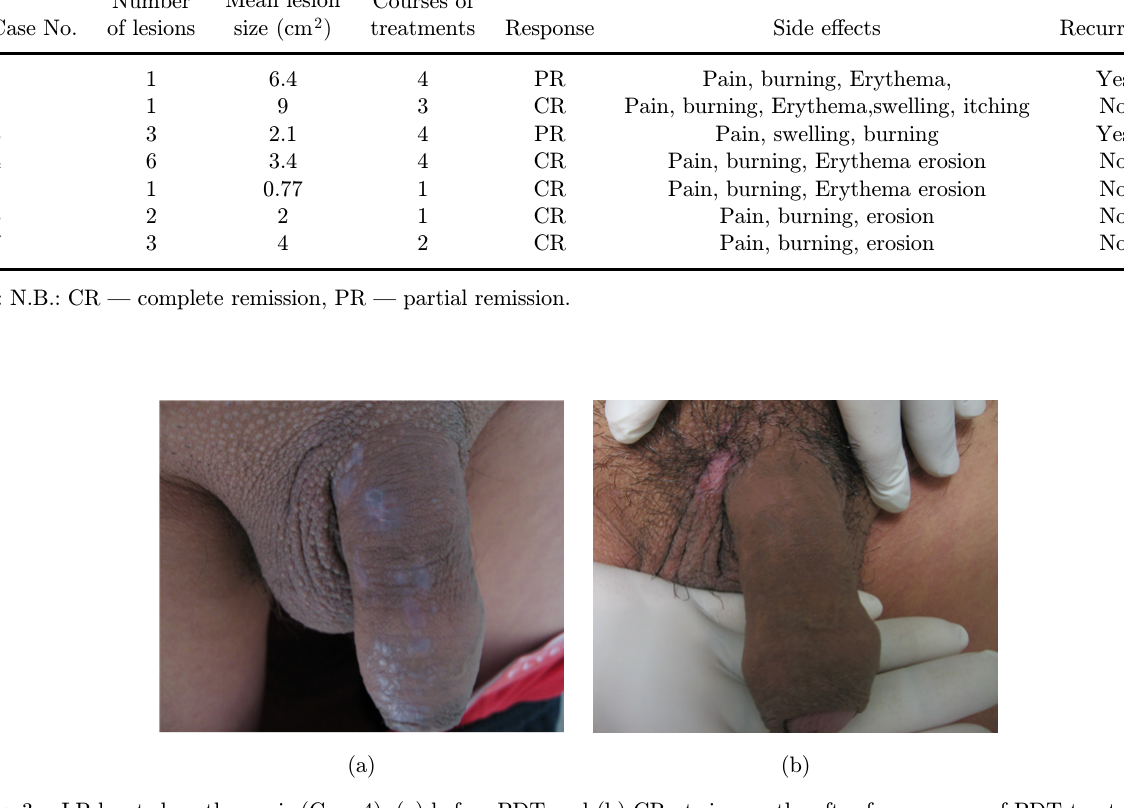
Fig. 3. LP located on the penis (Case 4). (a) before PDT and (b) CR at six months after four courses of PDT treatments.